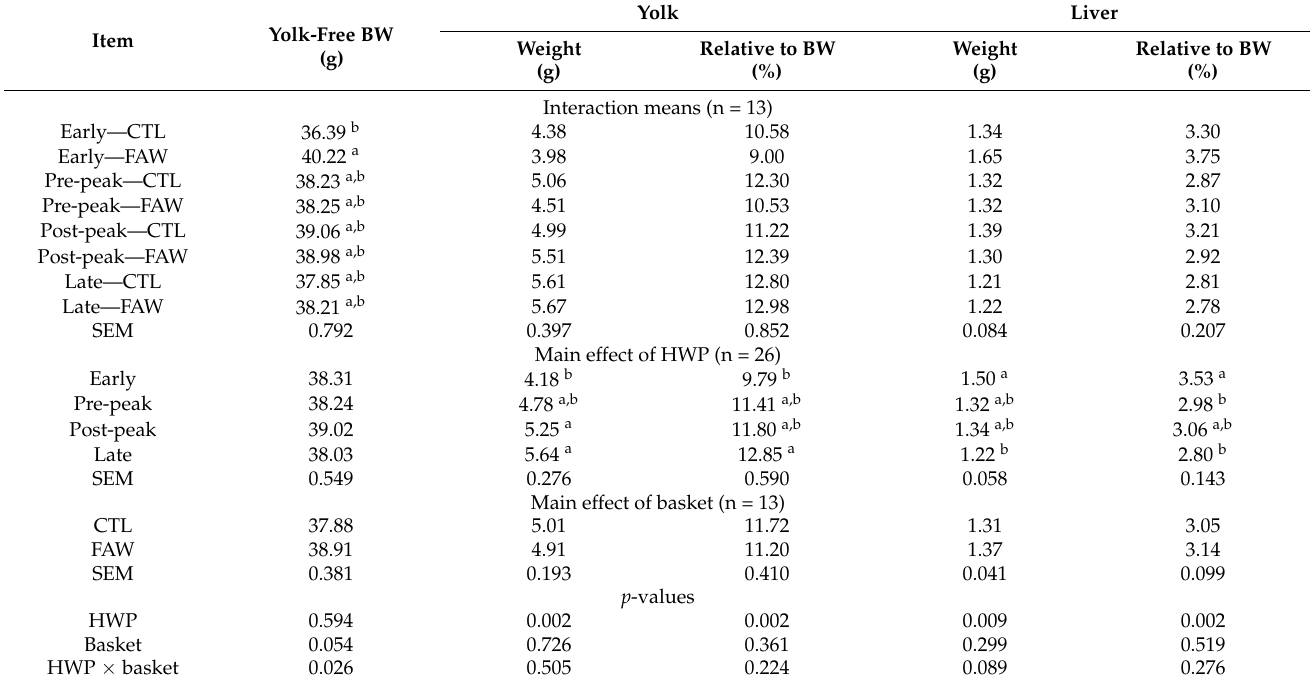
Table 2. Effects of hatch window period (HWP) and nutrient access of feed and water (FAW) or control (CTL) in the hatching basket on body, yolk, and liver weights of day-old broiler